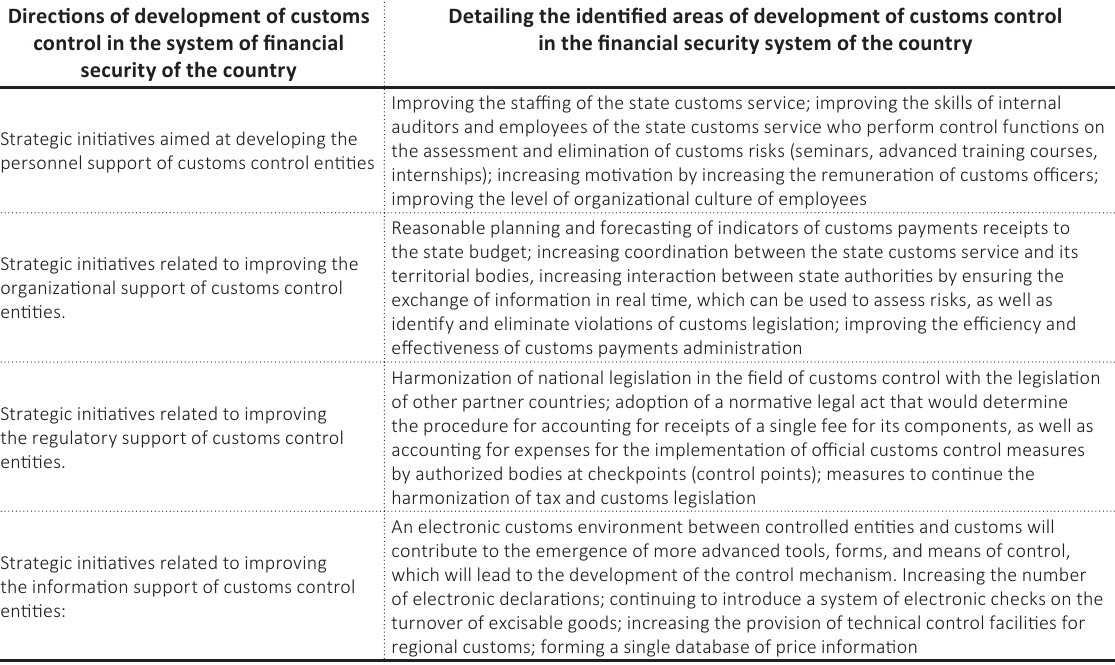
Table 4. Directions of development of customs control in the system of financial security of the country related to the structure of its mechanism Directions of development of